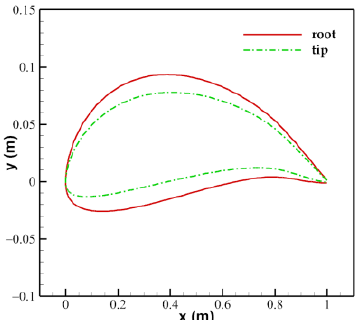
Figure 8. Schematic diagram of the blade airfoil.